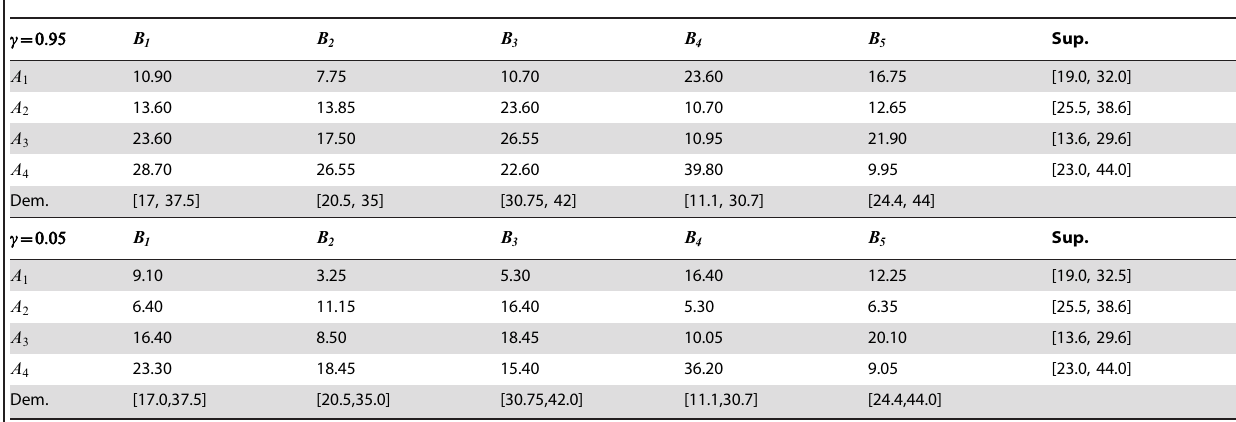
Table 2. The crisp transportation problem originated from Model